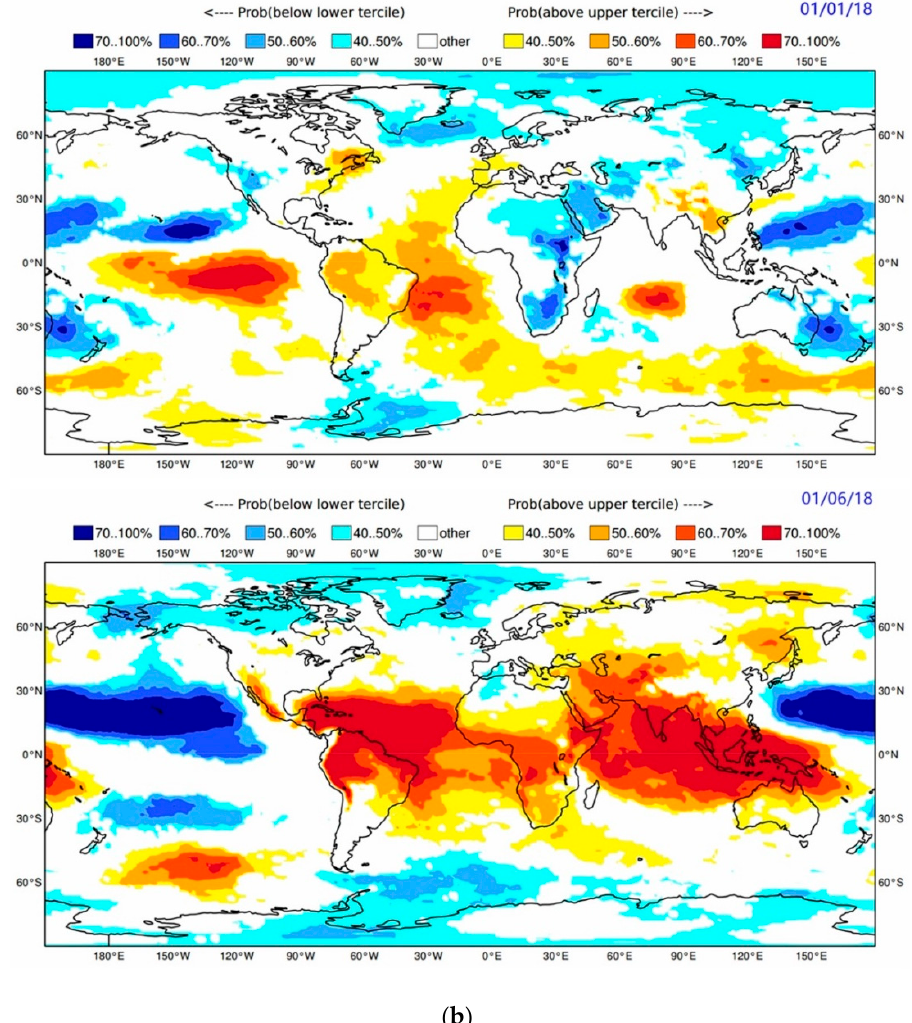
Figure 6. ( a ) Distribution of stations with seasonal biases between Saastamoinen ZHD estimates and radiosonde + ISA76 integrated ZHD estimates. The biases were fitted by a yearly sine function, including a phase factor. An upper (respectively lower) arrow means that the amplitude of the sine function was positive (respectively negative). No arrow means that no seasonal signal was visible.